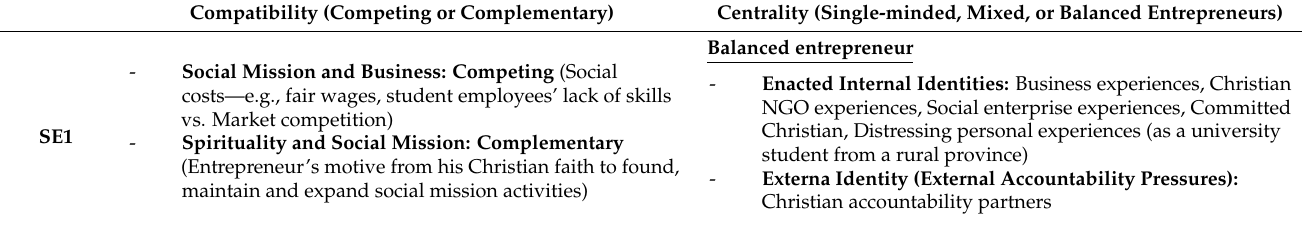
Table 2. Compatibility and centrality comparison between sample Christian social